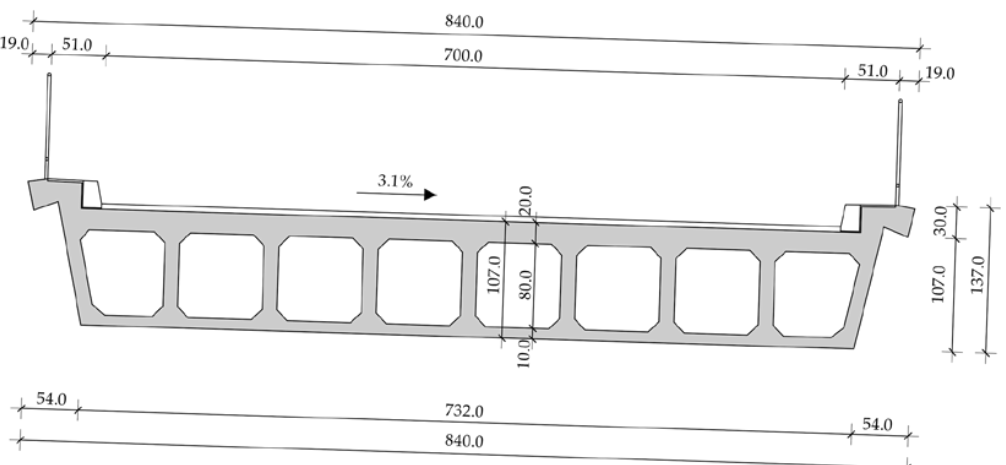
Figure 6. Longitudinal section of the first Case Study bridge (units in cm).